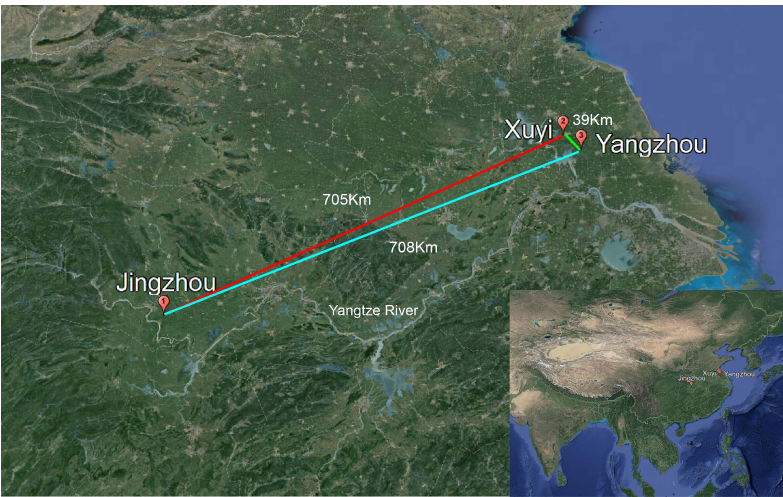
Figure 1. Sample locations: Jingzhou of Hubei province at the middle reaches of Yangtze river, and Yangzhou and Xuyi of Jiangsu province at lower reaches of Yangtze river. The distance between the sampling locations was